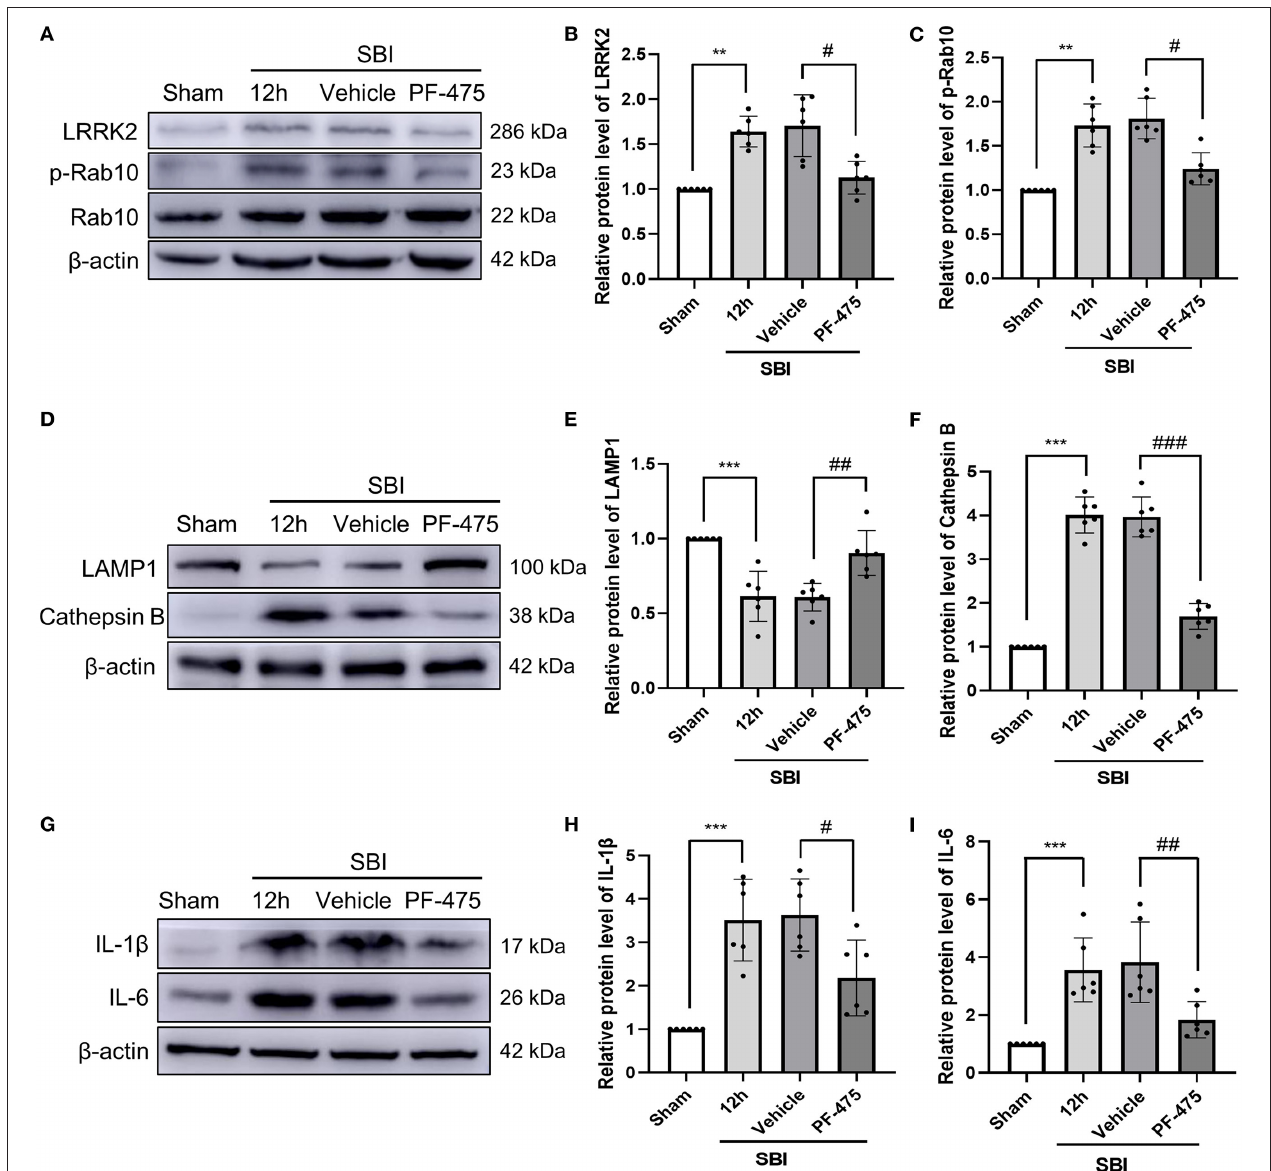
FIGURE 3 | Changes in protein levels of LRRK2 and p-Rab10, lysosomal damage and inflammation in damaged brain tissue after injecting PF-475. Western blot was used to detect the expression of LRRK2 (A,B) and Rab10/p-Rab10 (A,C) , LAMP1 (D,E) and Cathepsin B (D,F) , IL-1 β (G,H) , and IL-6 (G,I) in Sham, SBI, SBI + Vehicle and SBI + PF-475 12h after SBI. Protein levels were quantified with Image J software. Data = means ± SD. N = 6. ** P < 0.01, *** P < 0.005 vs. Sham, # P < 0.05, ## P < 0.01, ### P < 0.005 vs. SBI +